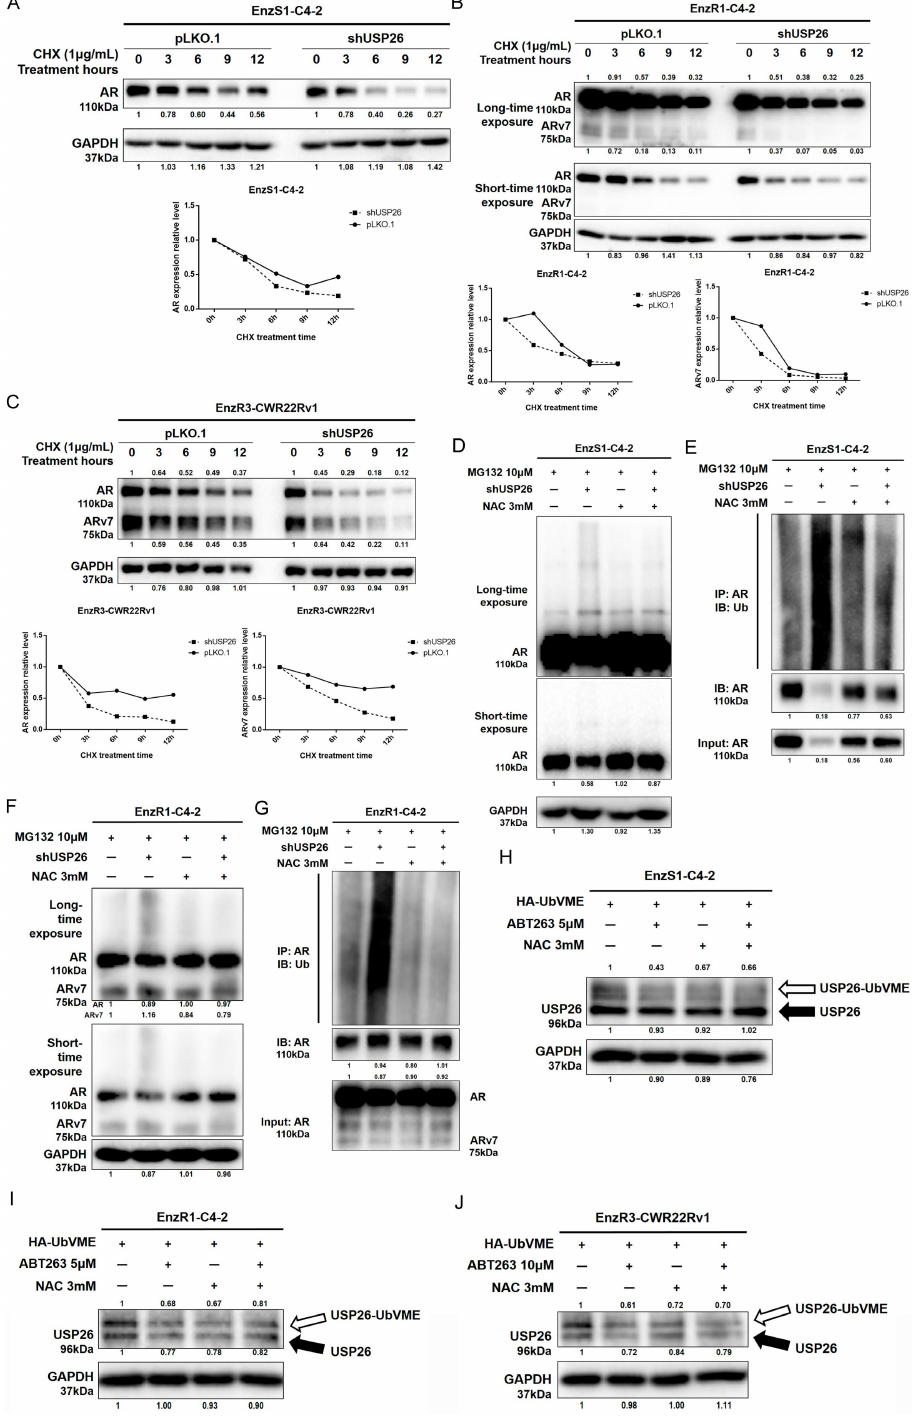
Figure 6. ABT263-induced cellular ROS inhibits USP26 activity leading to degradation of AR / ARv7. ( A–C ) USP26 contributes to protein stability of AR and ARv7. Cycloheximide (CHX) was used